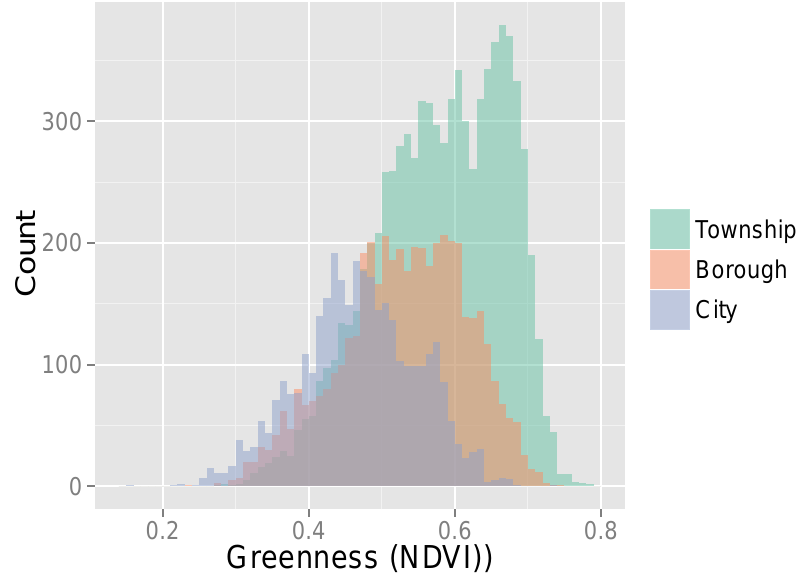
Figure 2. Distribution of greenness (NDVI) by community